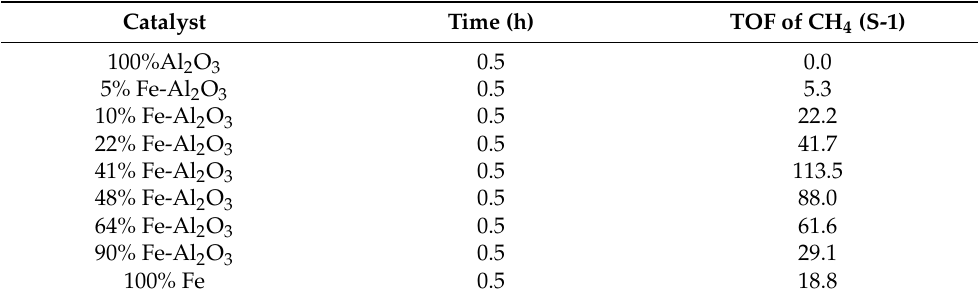
Table 4. The catalytic activity of iron catalysts prepared via fusion method with different iron loadings and tested at 750 ◦ C and 1 atm